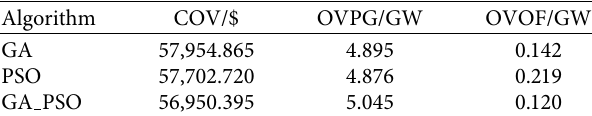
Table 2: Comparison of multiobjective optimization